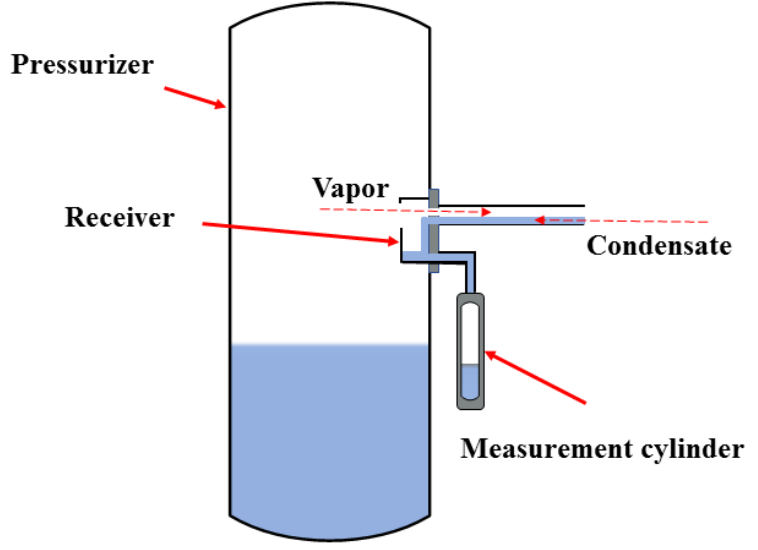
Figure 5. Condensate collection and measurement device.